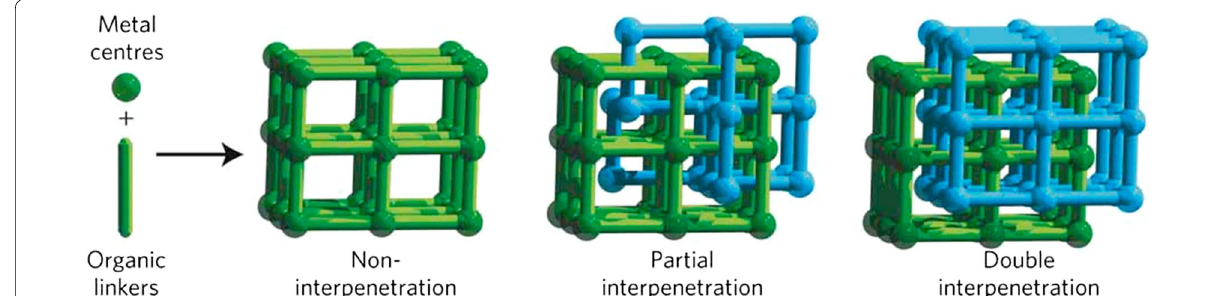
Fig. 2 NOTT-202 is composed of one dominant network (green) and one secondary partially formed network (blue) resulting in a unique partially interpenetrated framework (Reprinted by permission from Macmillan Publishers Ltd: Nature Materials, Ref [38], copyright